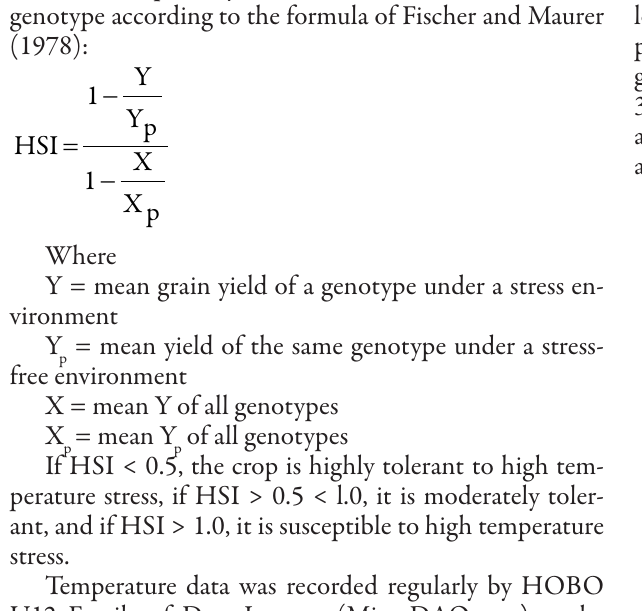
Fig. 1. Temperature (°C) during the wheat growing period. Source: Meteorological Station, Wheat Research Centre, Na- shipur, Dinajpur,